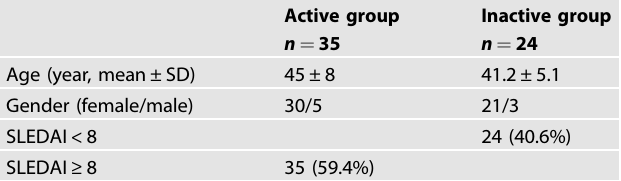
Table 1. The basic information of SLE